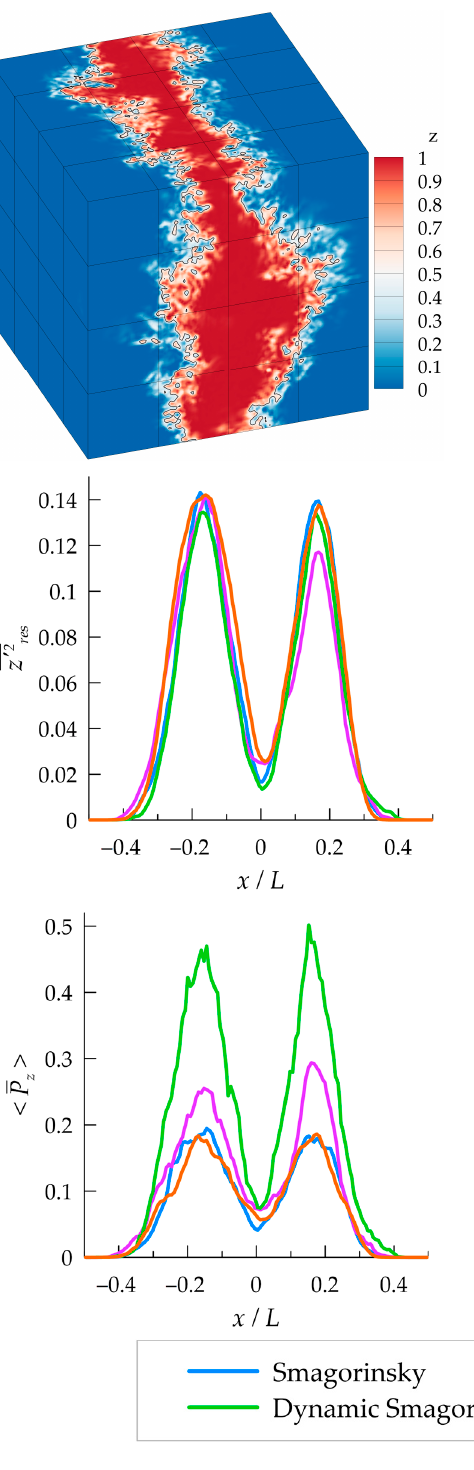
Figure 9. Time instance 𝑡 = 0.10𝑇 (cid:2868) . Designations as in Figure 7.